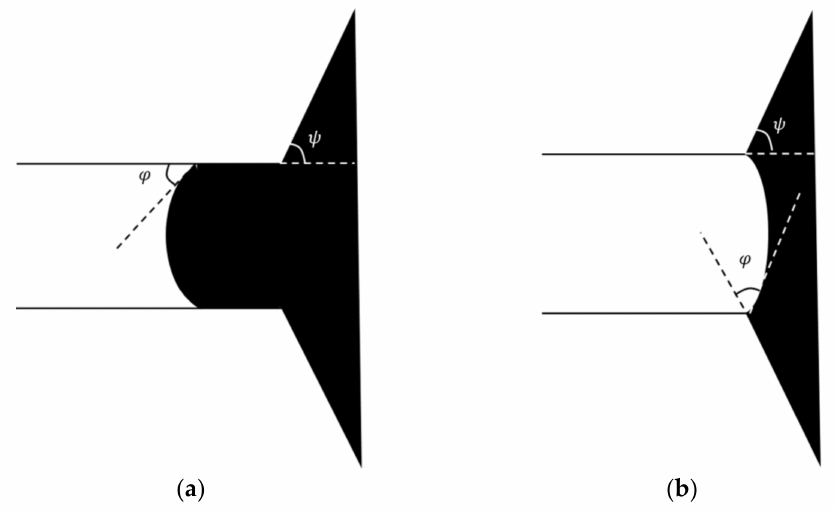
Figure 3. The interface morphology when the oil–water interface is in different positions: ( a ) the oil–water interface is in the throat; ( b ) the oil–water interface is in the pore throat interface. σ is the interfacial tension coefficient and R is the pore channel radius. Under